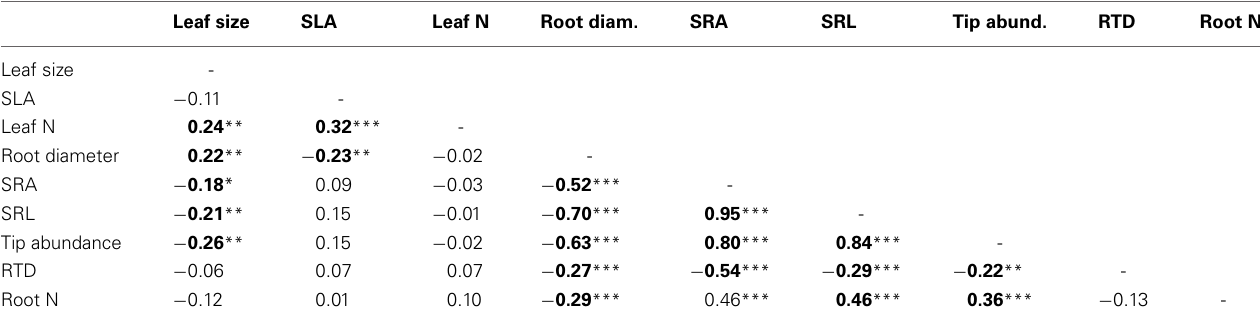
Table 5 | Pearson correlation coefficients for linear relationships between three leaf and six root traits across the eight demes ( n = 154). Leaf size SLA Leaf N Root diam.